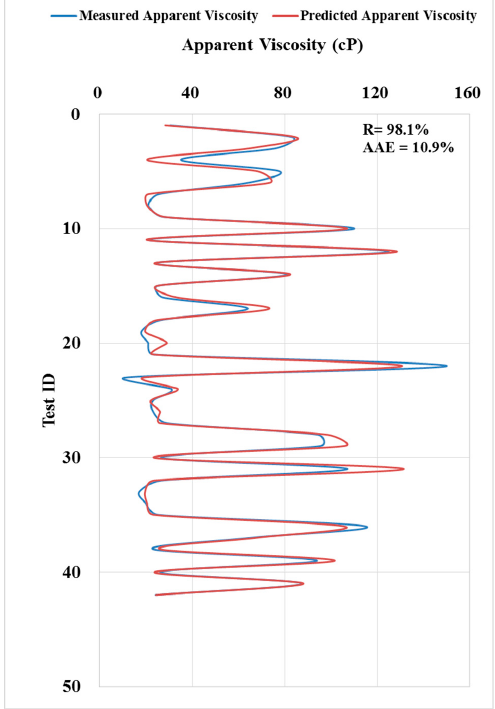
Figure 9. Apparent viscosity prediction using an artificial neural network for testing data (42 samples).